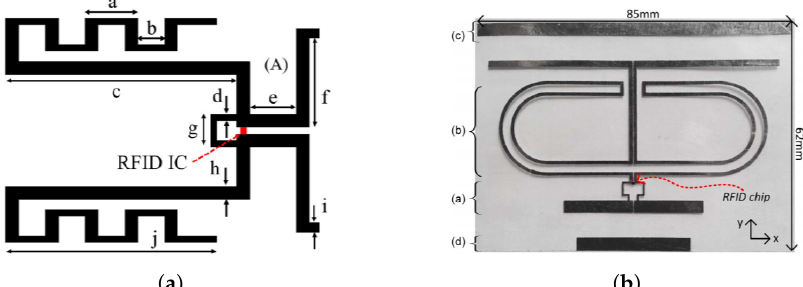
Figure 13. Harmonic RFID tag realization using conventional RFID IC ( a ) as in [73], [Reproduced with permission from D. Kumar, Harmonic RFID communication using a conventional ultra high frequency (UHF) system; published by IEEE, 2019.] and ( b ) as in [74]. [Reproduced with permission from G.A. Vera, Third harmonic exploitation in passive UHF RFID; published by IEEE, 2015].